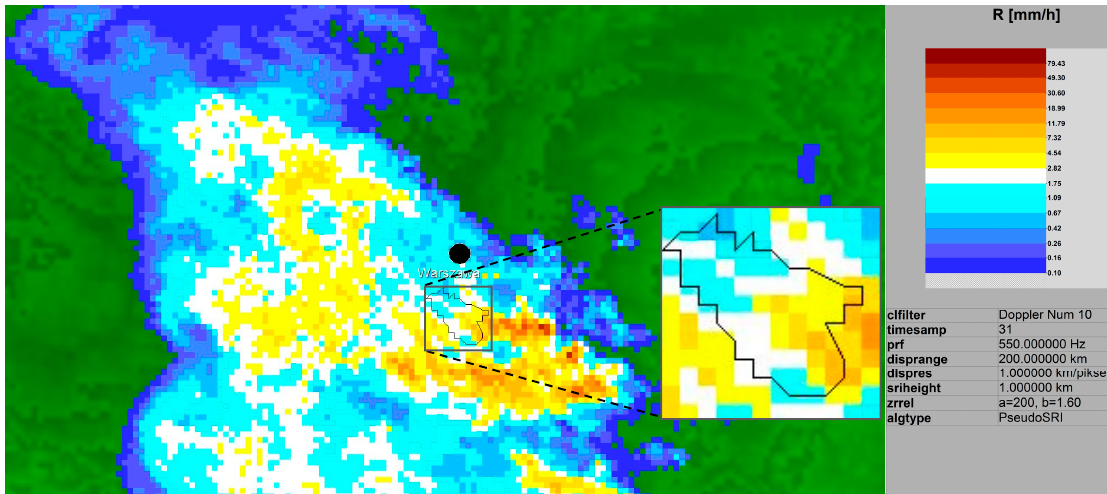
Figure 3. SRI (Surface Rainfall Intensity) product (map of rainfall intensity) and area covering the analyzed catchment (156 pixels).